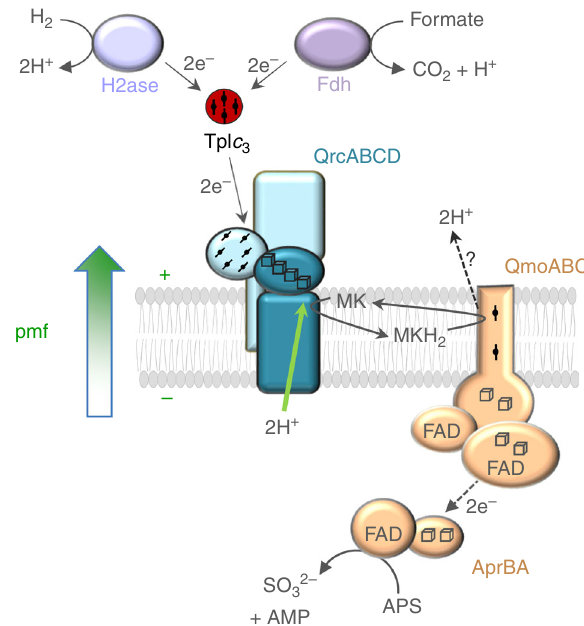
Fig. 1 Physiological role of the QrcABCD complex. The QrcABCD complex accepts two electrons from the TpI c 3 and reduces MK. We show here that uptake of 2H + for MK reduction occurs from the cytoplasm, thereby contributing to the pmf . MKH 2 may be oxidized by the QmoABC complex. The QrcCD dimeric redox module is highlighted by a darker shade of blue. H2ase hydrogenase, Fdh formate dehydrogenase, APS adenosine 5 ′ -phosphosulfate, AprAB adenosine 5 ′ -phosphosulfate